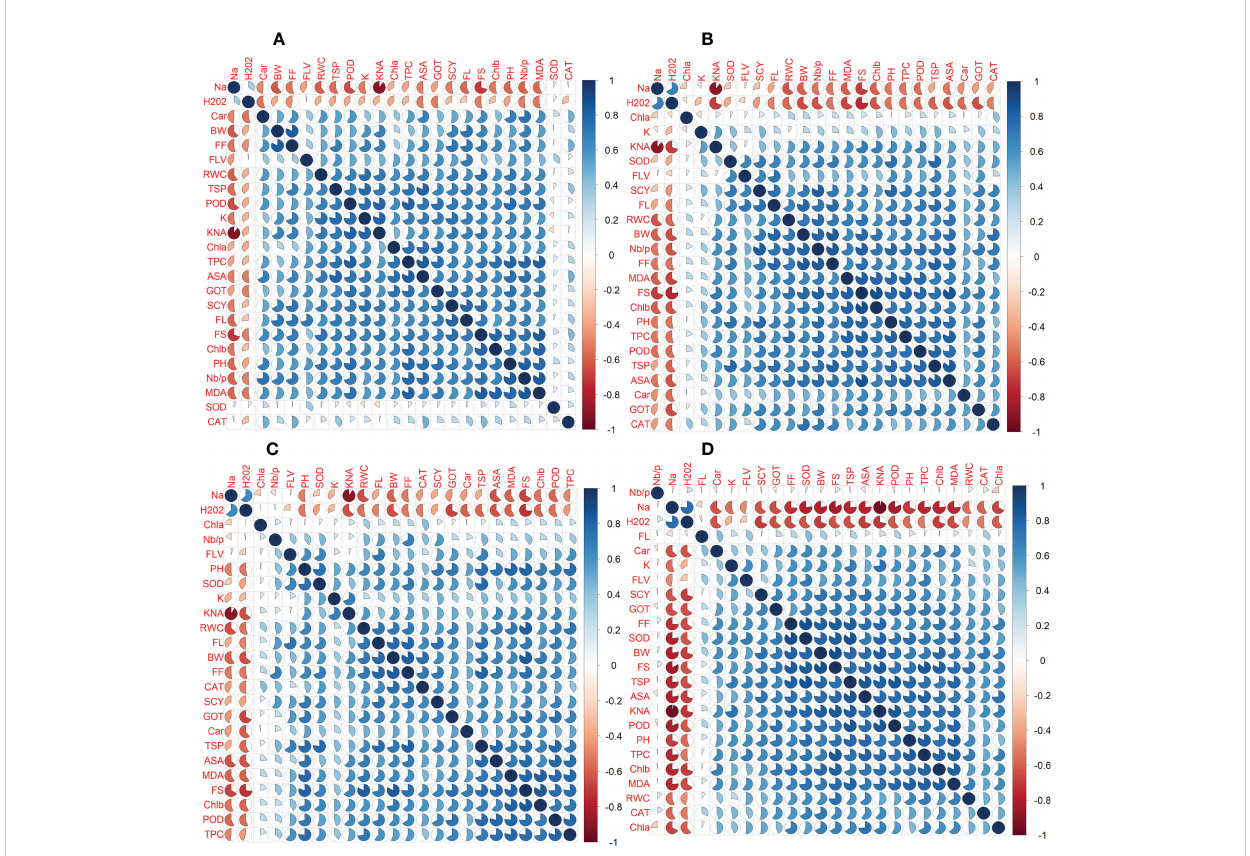
FIGURE 6 Second year correlation analysis based on mean values of various agro-physiological, biochemical, and fi ber quality traits of 30 cotton genotypes. (A) control, (B) drought stress (D) , (C) heat stress (H), and (D) drought + heat stress (DH). ASA, ascorbic acid; BW, boll weight; CAR, carotenoids; CAT, catalase; Chla, Chlorophyll a; Chlb, Chlorophyll b; FF, fi ber fi neness; FL, fi ber length; FLV, fl avonoids; FS, fi ber strength; GOT, ginning out turn percentage; H202, Hydrogen peroxide; K+, potassium content; K+/Na+, the potassium over sodium ratio; MDA, malondialdehyde; Na+, the sodium contents; NBP, Number of bolls per plant; PH, plant height; POD, peroxidase; RWC, Relative water content; SCY, seed cotton yield; SOD, superoxide dismutase; TPC, total phenolic content; TSP, total soluble